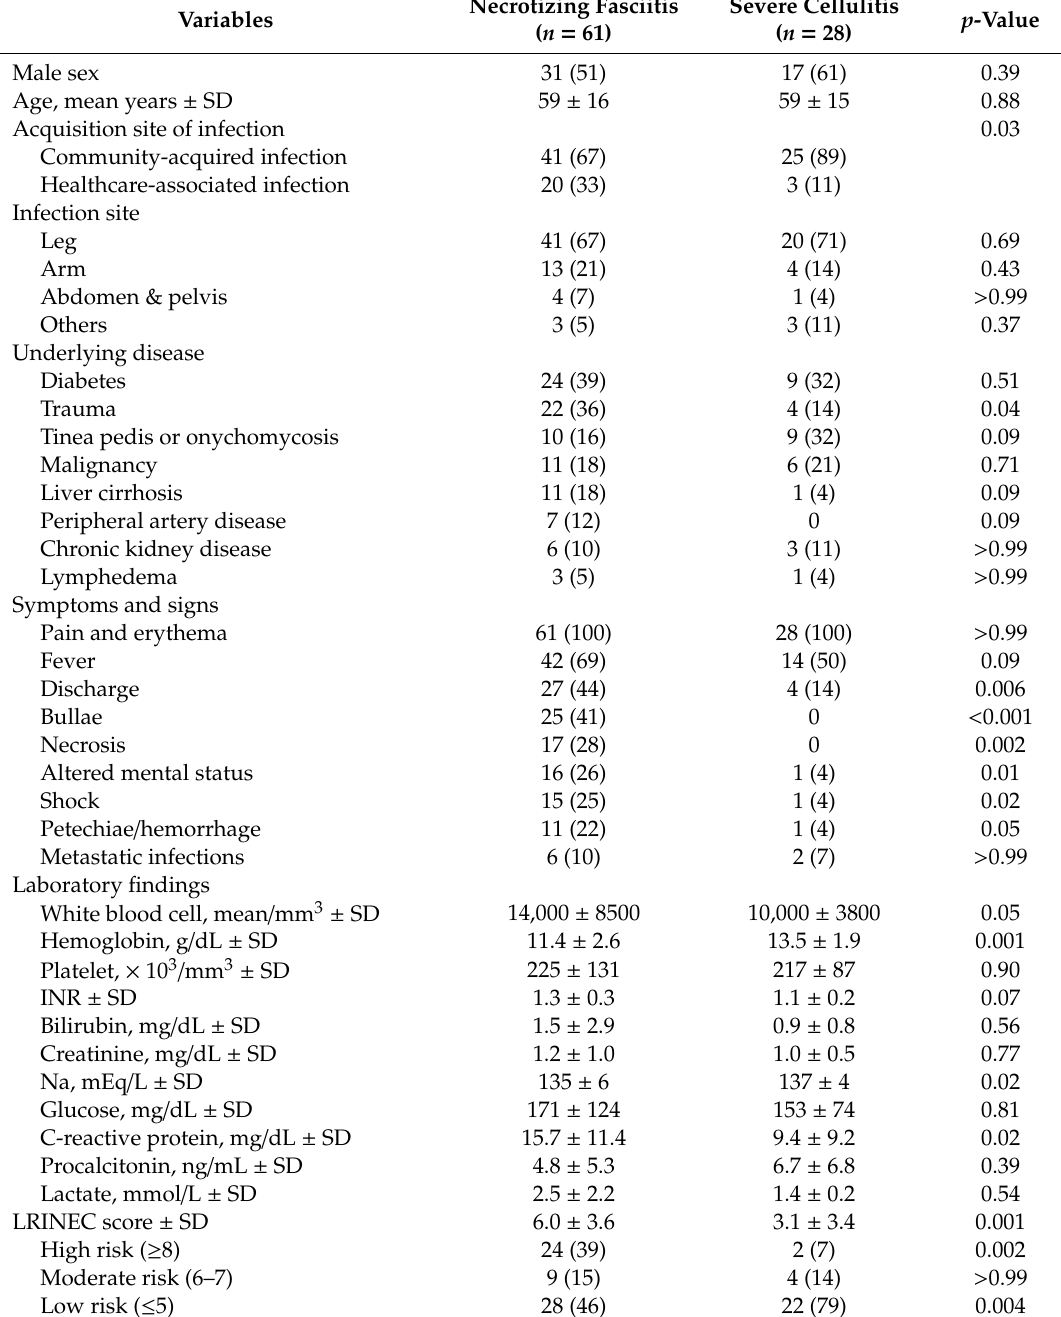
Table 1. Clinical and laboratory characteristics, microbiology, and outcomes of patients with necrotizing fasciitis and severe